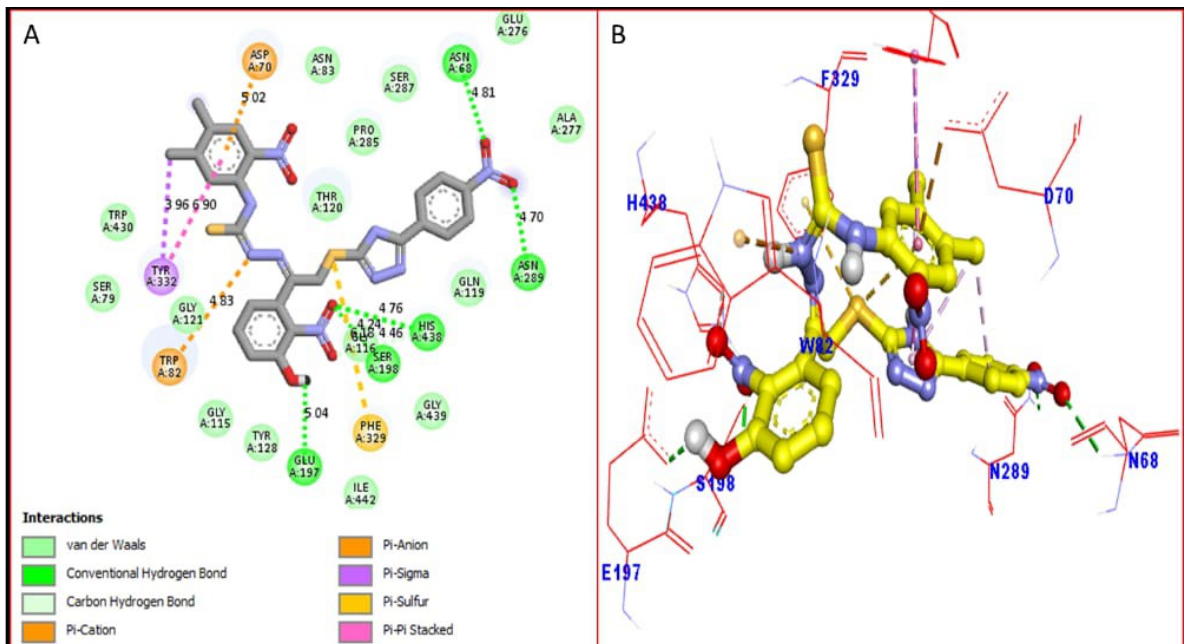
Figure 5. Protein–ligand interaction (PLI) profile of analogue 6i against acetylcholinesterase (AChE): ( A ) 2D; ( B ) 3D.